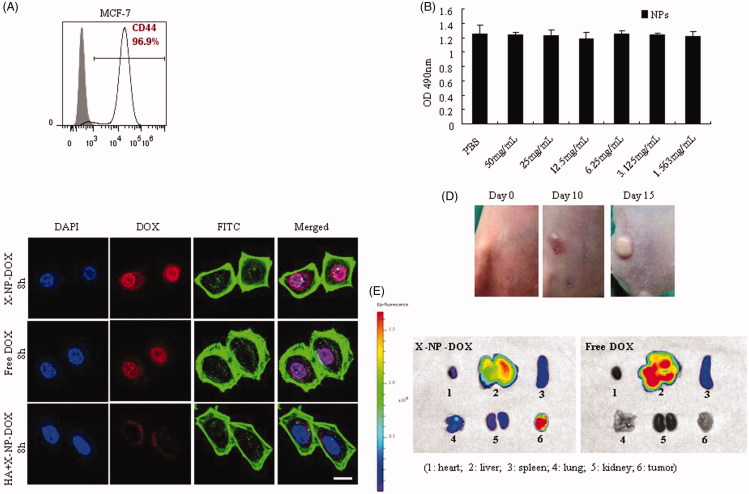
Cellular uptake, drug release in vitro or in vivo. MCF-7 cells, which express high level of CD44 receptors, were used to analyze the cytotoxicity of HA-Lys-LA10 X-NPs, the cellular uptake and intracellular drug-release behaviors of DOX-loaded HA-Lys-LA X-NPs (X-NP-DOX). Meanwhile, mouse orthotopic model was established and used to analyze the biodistribution of X-NP-DOX in vivo. (A) The expression of CD44 on breast cancer cell line was analyzed by flow cytometry. MCF-7 expresses high level of CD44 (96.9%). (B) The CCK8 results showed that HA-Lys-LA10 X-NPs were nontoxic toward the proliferation of MCF-7 compared with PBS. (C) CLSM analysis showed that pericellular DOX distribution in MCF-7 cells incubated with X-NP-DOX for 8 h. At 8 h, DOX fluorescence of X-NP-DOX-treated cells reached a high level, and mainly located in the nuclei as compared with that of free DOX. Free HA-pretreated MCF-7 cells displayed a remarkably low DOX fluorescence owing to the blocked binding site by free HA, confirming that X-NP-DOX was taken up by MCF-7 cells via a receptor-mediated mechanism. For each panel, the images from left to right show cell nuclei stained by DAPI (blue), DOX fluorescence in cells (red), cytoskeleton stained by phalloidin–FITC (green), and overlays of the three images. (D) Mice were injected subcutaneously into the first mammary fat pad with 1 × 106 MCF-7 cells suspended in PBS. Tumor volume was estimated by using the formula width2 × length ×0.52 in mm3. (E) The distribution of released DOX in tumor-bearing mice, ex vivo DOX fluorescence images of tumor and several major organs including heart, liver, spleen, lung, and kidney after 12-h i.v. injection of X-NP-DOX or free DOX were taken. The ex vivo fluorescence images showed that X-NP-DOX had strong DOX fluorescence in the tumor, which was significantly stronger than that in the major organs such as heart, liver, spleen, lung, and kidney compared with free DOX.